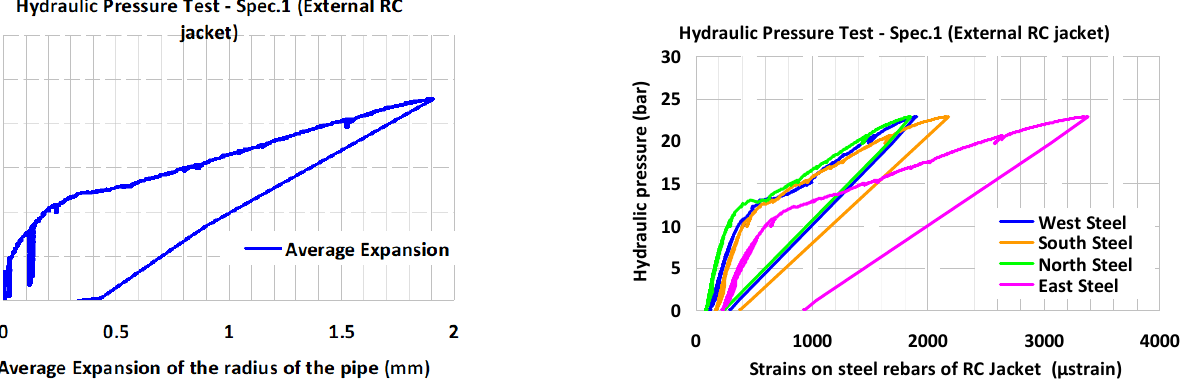
Figure 18. Measured response for Specimen 1 with fully active prestressing and an external RC jacket: ( Left ) average radial expansion of the pipe radius; ( Right ) radial strains of the radial reinforcing bars of the external RC jacket (1 bar = 0.1 N/mm 2 ).